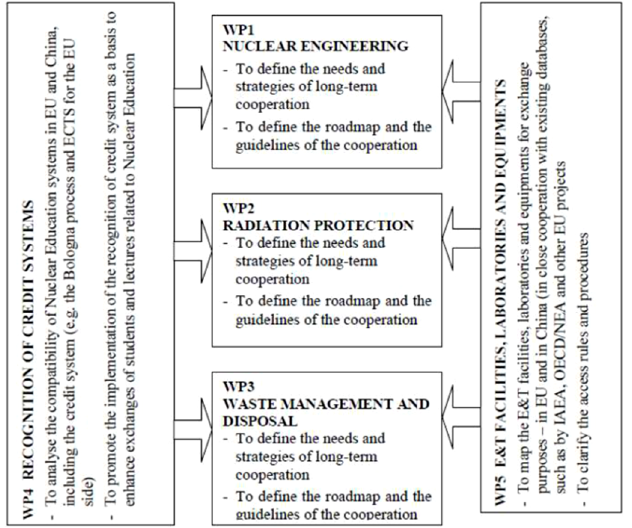
Fig. 5. Functional sketch of the ECNET